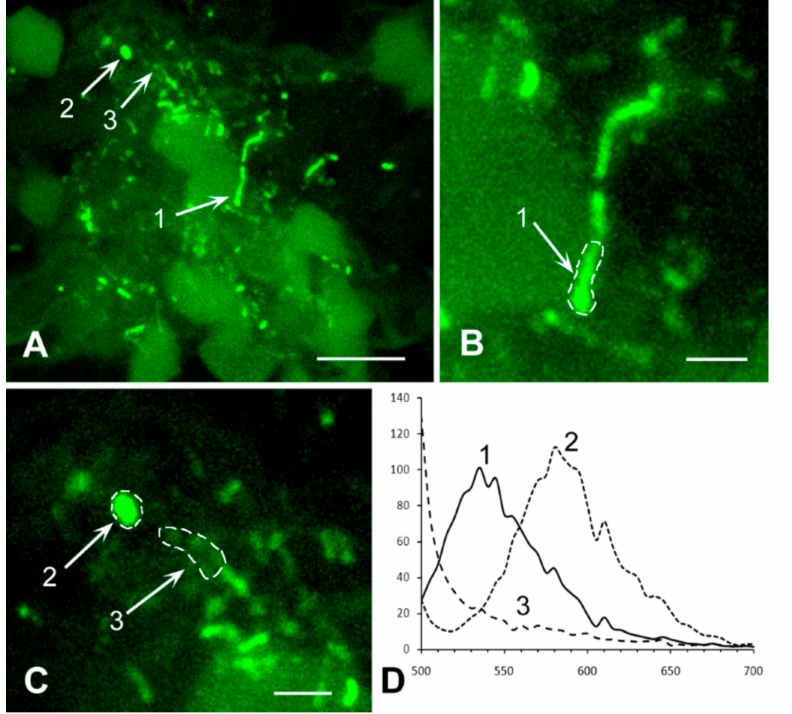
Figure 5. Immunolabelling of M. tuberculosis in lung tissue with specific staining and non-specific fluorescence. A low magnification image ( A ) shows aggregations of rounded and rod-shaped fluorescent structures, whereas specific and non-specific fluorescence is indistinguishable. High magnification of the selected structures is shown in ( B , C ), and their emission spectra (the ROIs are indicated by dotted lines) are presented in ( D ). Specific labelling, with the emission spectrum similar to that of Alexa-488 ( 1 ) can be distinguished from non-specific fluorescence, with di ff erent emission spectra ( 2 , 3 ). Scale bars: ( A ) = 10 µ m; ( B , C ) = 2 µ m. The abscissa shows emission wavelength (nm); the ordinate shows relative